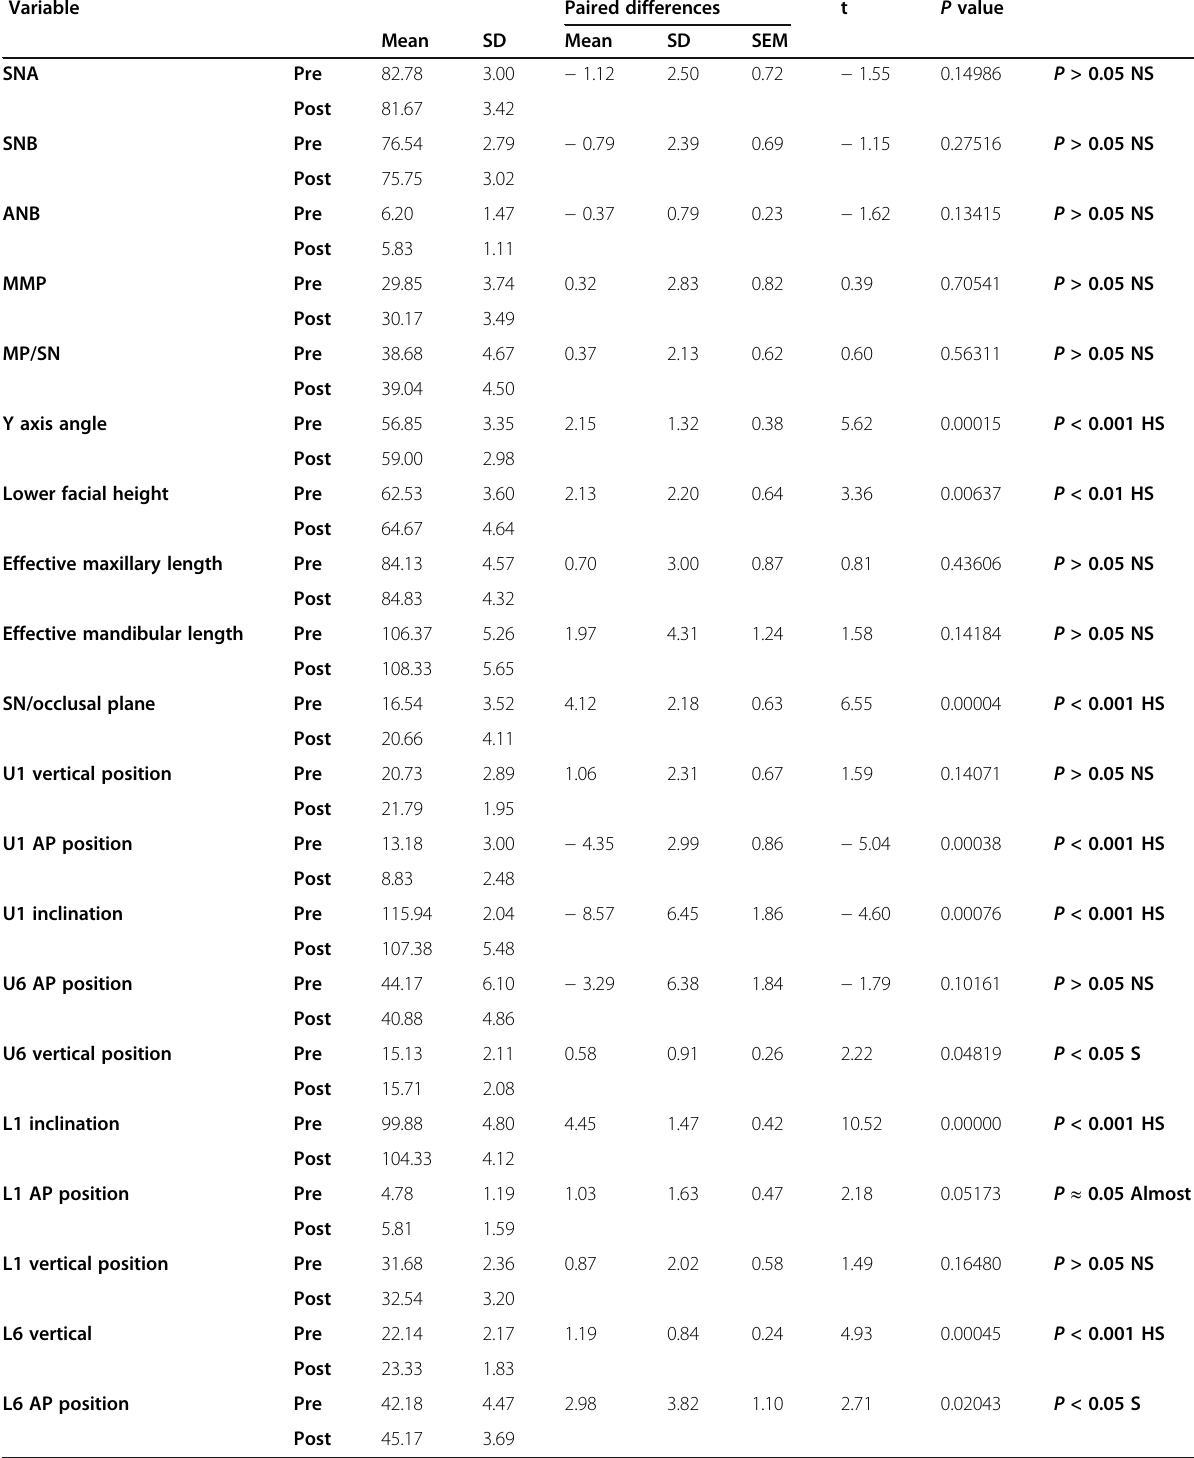
Table 3 Paired t test for comparing the dental and skeletal changes after class II elastics phase for the mini-implant group Variable Paired differences